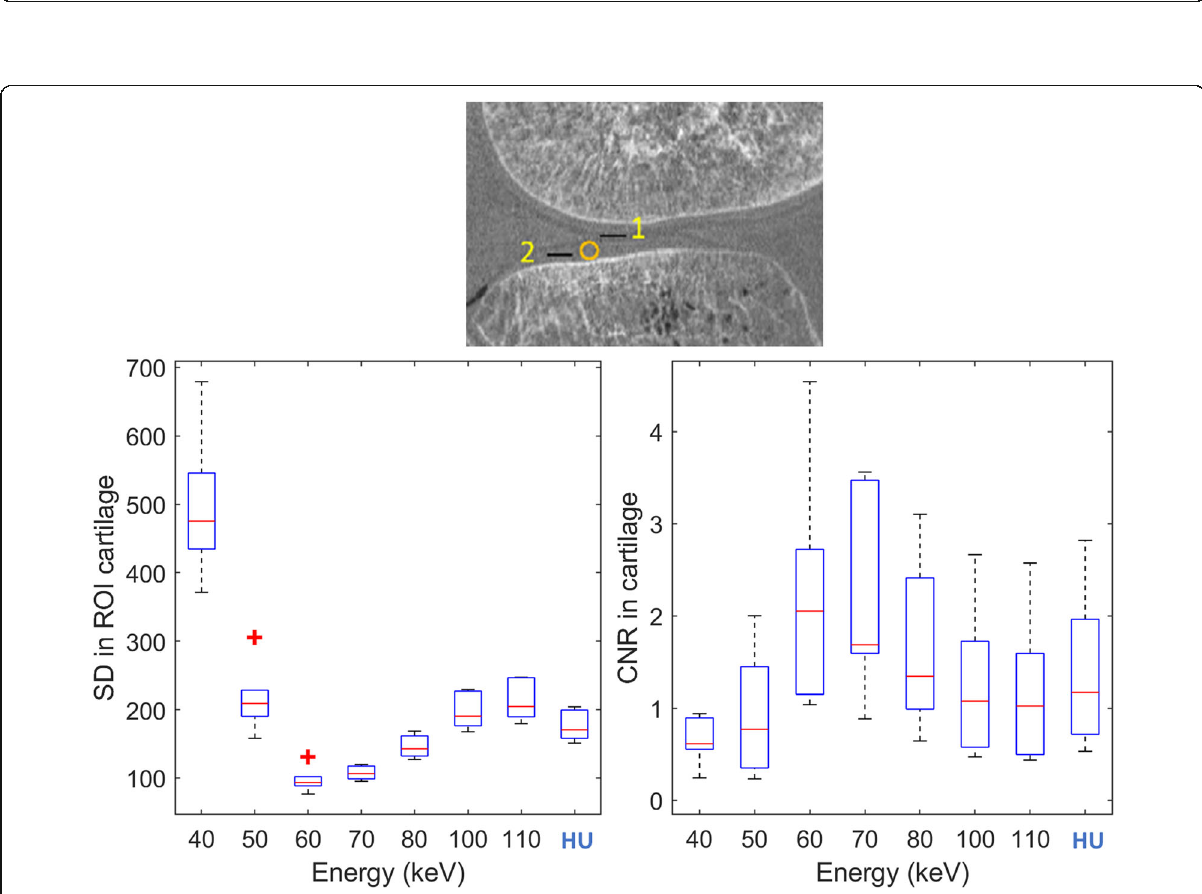
Fig. 2. Noise standard deviation (SD) (left) and contrast-to-noise ratio (CNR) (right) for the cartilage for all of the monoenergetic images (40 − 110 keV) and the conventional image (HU). Plots display median and confidence intervals across the seven samples, with red crosses to indicate outliers. Top: Region-of-interest masks used for the analysis. Noise is computed as the SD within the circular region in the cartilage. CNR is computed as the contrast given by black lines 1 and 2 divided by the